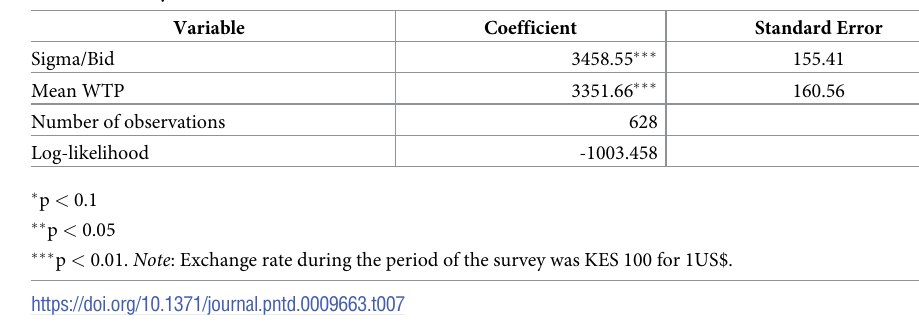
Table 7. Logistic parameter estimates for WTP for tsetse repellent collar (without socio-economic characteristics) in Kwale